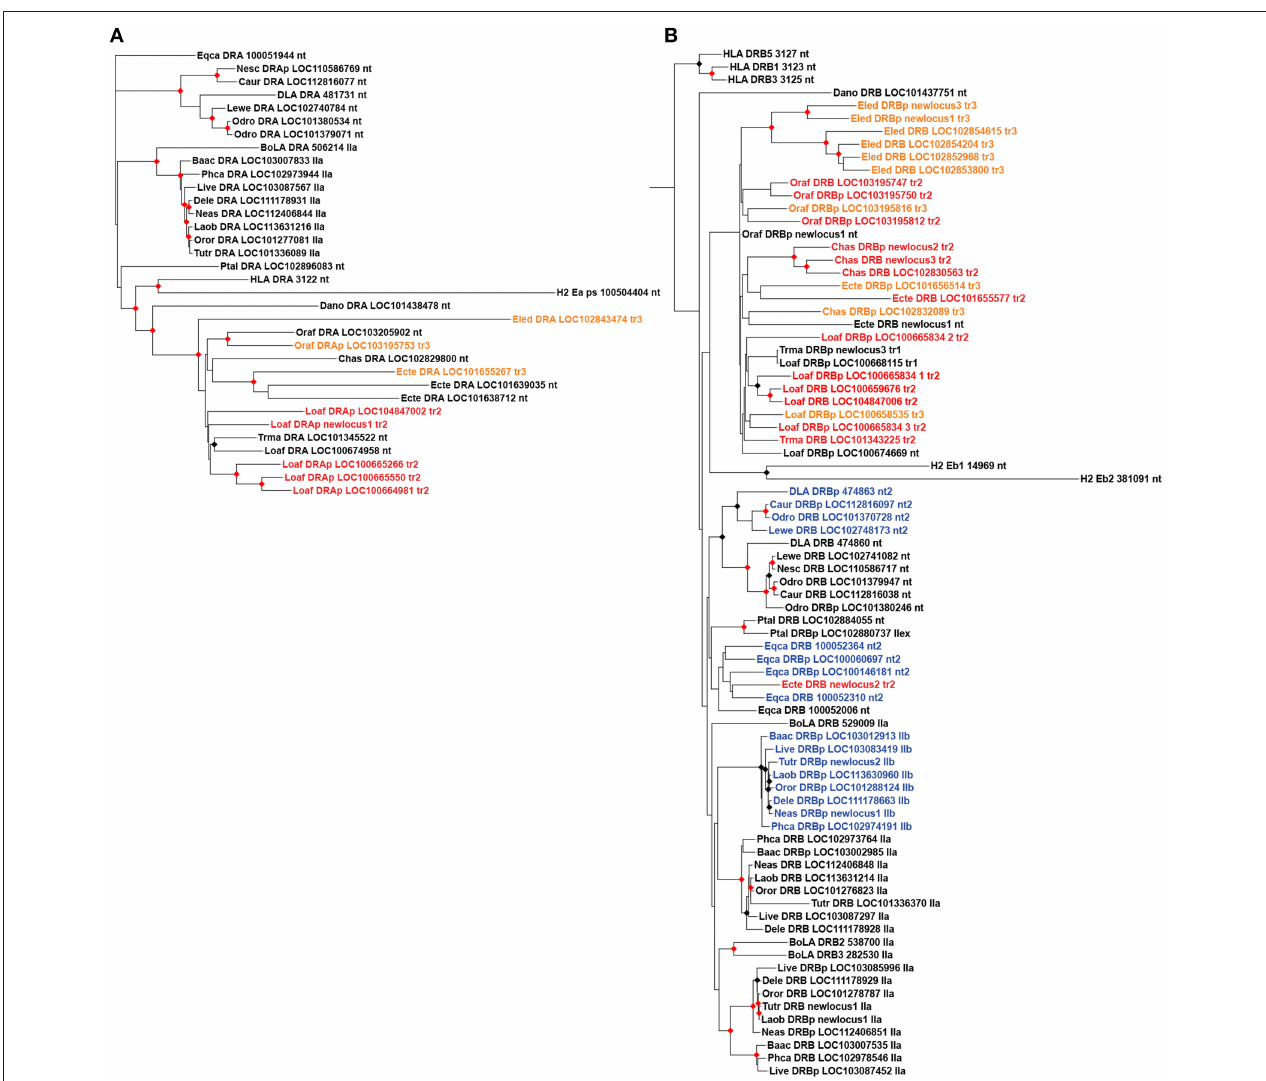
FIGURE 5 | Maximum likelihood phylogenetic trees of DR MHC class II genes and pseudogenes. (A) DRA introns 1, 2, and 3 phylogeny; (B) DRB introns 1, 2, 3, 4, and 5 phylogeny. On the sequence positions: “nt” refers to not translocated; in blue, "nt2" refers to genes between DQ and DO , and IIb to genes located on class IIb region in Cetartiodactyla, in blue; “tr1” refers to translocated between C6orf106 and SNRPC; “tr2” between TULP1 and FKBP5, in red; “tr3” between CLPS and LHFPL5, in orange; “p” refers to pseudogenes. Black and red circles indicates > 80 and > 95% support values, respectively. L. africana , Loaf; T. manatus , Trma; O. afer , Oraf; El edwardii , Eled; C. asiatica , Chas; E. telfairi , Ecte; D. novemcintus , Dano; B. acutorostrata , Baac; D. leucas ; Dele; L. vexillifer , Live; N. asiaeorientalis , Neas; O. orca , Oror; L. obliquidens , Laob; T. truncates , Tutr; P. catodon , Phca; C. ursinus , Caur; N. schauinslandi , Nesc; L. weddelli , Lewe; O. rosmarus , Odro;